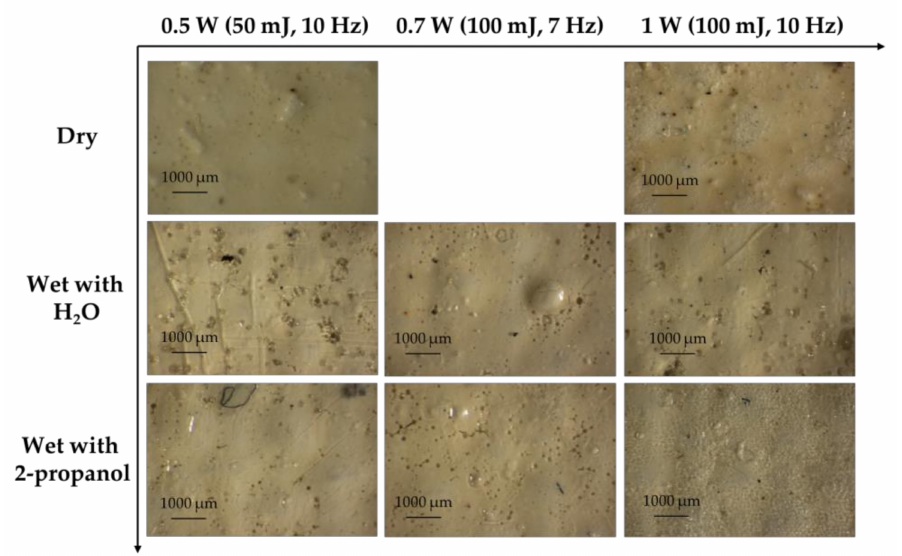
Figure 14. The microscopic images (32 × ) of the eight sections of P B67 varnished lead white tempera mock-ups after different laser cleaning conditions and